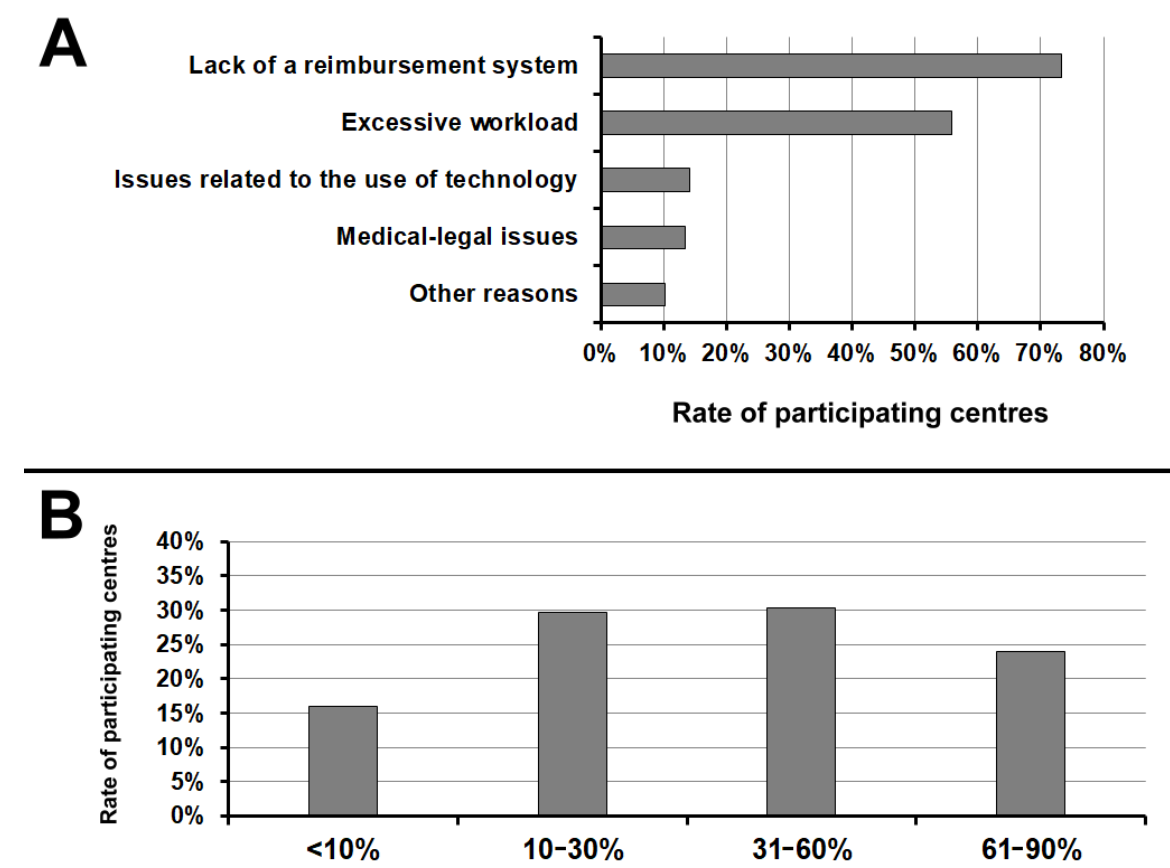
Figure 4. ( A ) Main barrier to the implementation of remote monitoring. ( B ) Rate CIED patients who will be followed up by remote monitoring in the next 5 years. CIED, cardiac implantable electronic device.